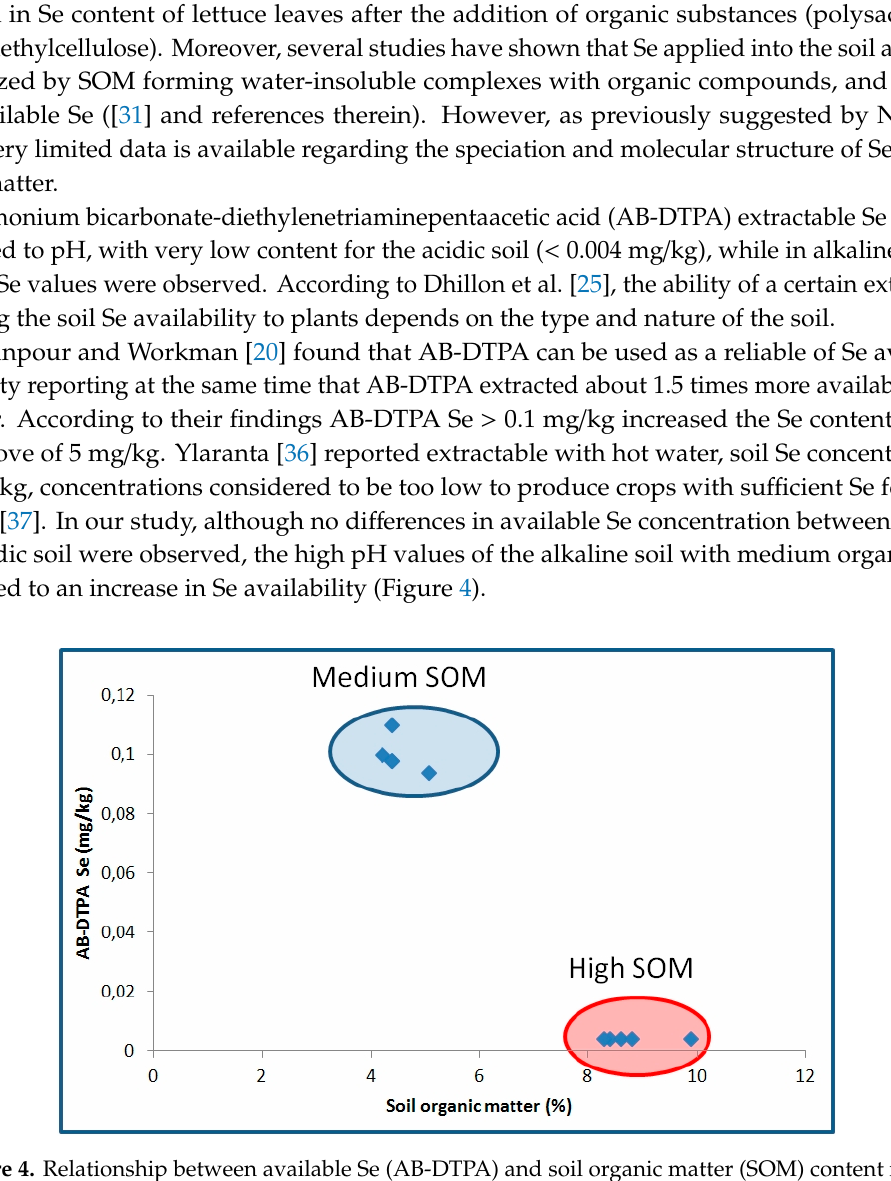
Figure 4. Relationship between available Se (AB-DTPA) and soil organic matter (SOM) content in the alkaline soil amended with sodium selenate. alkaline soil amended with sodium